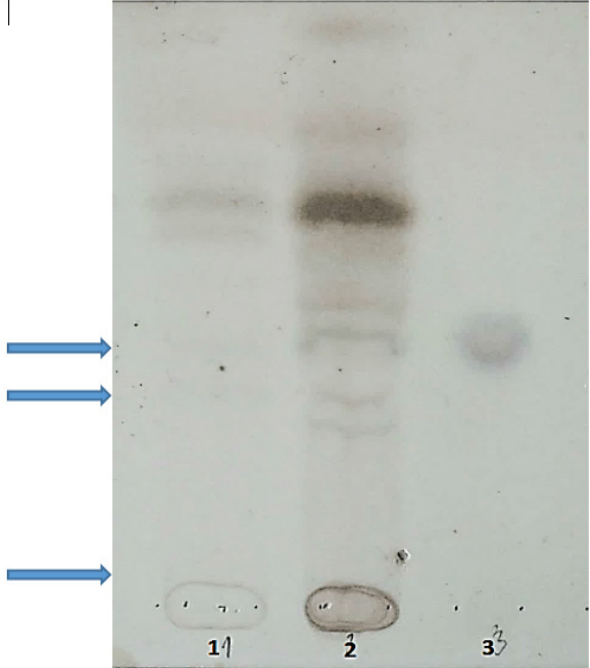
Figure 5. Thin-layer chromatography of sialooligosaccharides in urine. Path 1—healthy donor, path 2—described patient, path 3—free sialic acid. Desalted urine samples were mounted on the Silica G-60 precoated plate, developed in n-butyl alcohol:glacial acetic acid:water (50:25:25) and stained with resorcinol reagent. Arrows indicate sialooligosaccharides, which were slightly violet in the original image of the TLC plate. Bands of oligosaccharides in the control person were brown.